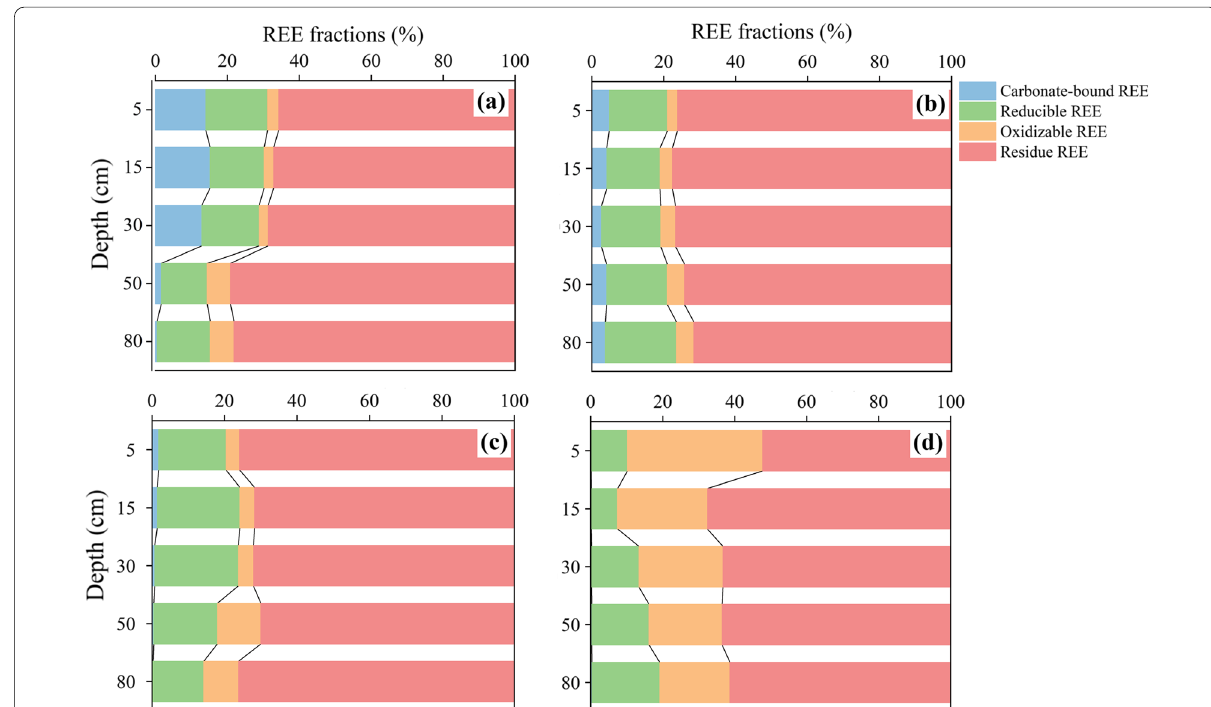
Correlations among REE geochemical fractions, climatic factors and soil properties Across all sites, the carbonate-bound fractions were negatively correlated with aridity index (AI) (Table 1, r – 0.81 , P < 0.01) and mean annual precipitation = (MAP) (Table 1, r – 0.85 , P < 0.01), but positively cor- = related with mean annual temperature (MAT) (Table 1, r 0.83 , P < 0.01) and potential evapotranspiration (PET) = (Table 1, r 0.86 , P < 0.01). The reducible fractions had = no correlations with AI and MAP, but had but had posi- tive correlations with MAT (Table 1, r 0.48 , P < 0.01) = and PET (Table 1, r 0.46 , P < 0.01). In contrast, the oxi- = dizable fractions showed positive correlations with AI (Table 1, r 0.81 , P < 0.01) and MAP (Table 1, r 0.77 , = = P < 0.01), and negative correlations with MAT (Table 1, r – 0.71 , P < 0.01) and PET (Table 1, r – 0.68 , P < 0.01). = = There were no discernible relationships between carbonate-bound REE concentrations and total Fe– Mn abundances and clay contents (Table 1). There were positive correlations between carbonate-bound fractions and pH values (Table 1, r 0.52 , P < 0.05), = total inorganic carbon (TIC) concentrations (Table 1, r 0.46 , P < 0.05), and the negatively correlation = with total organic carbon (TOC) (Table 1, r – 0.58 , = P < 0.01). The reducible fractions were only